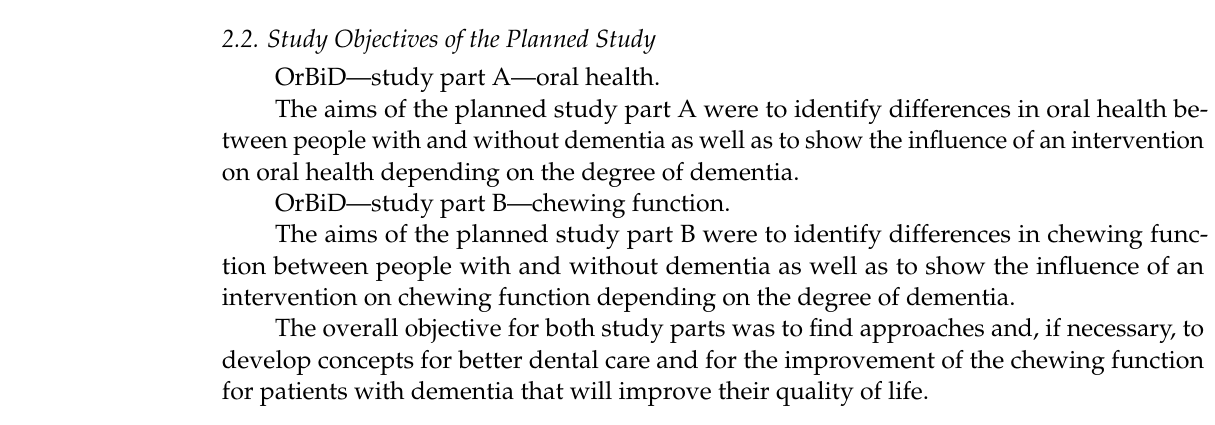
Table 1. OrBiD study design including evaluation time-points, intervals between the evaluation time-points and the allocation to the experimental and control group in the study parts A—oral health and B—chewing function (Exp—experimental group, Con—control group) * See “Supplementary Material File S2 ([15,19,22–37])—Measuring instruments and evaluation methods” for an overview of measurements at individual evaluation